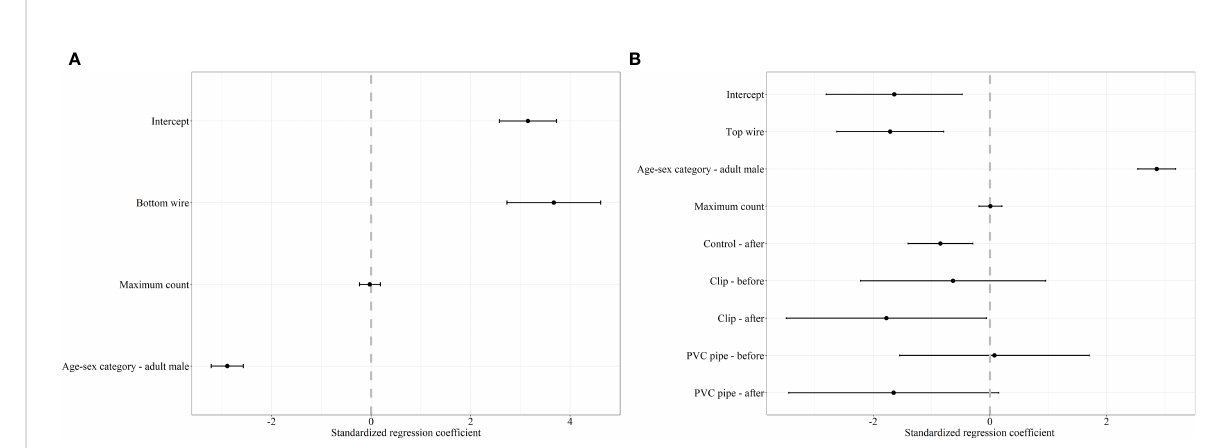
FIGURE 2 Standardized regression coef fi cients and 95% CI for the top model of the decision to cross under (A) and over (B) a fence by mule deer. The regression coef fi cient for the decision of mule deer to cross under and over was averaged between two competing models with D AICc < 2.0. We considered bottom wire height, top wire height, area (reference category – AB), sex-age (reference category – adult female), maximum count, snow (reference category – absent), and treatment-period (reference category – control-before) as covariates in our mixed effects logistic regression analysis. Covariates whose 95% CI overlap 0 are considered noninformative.